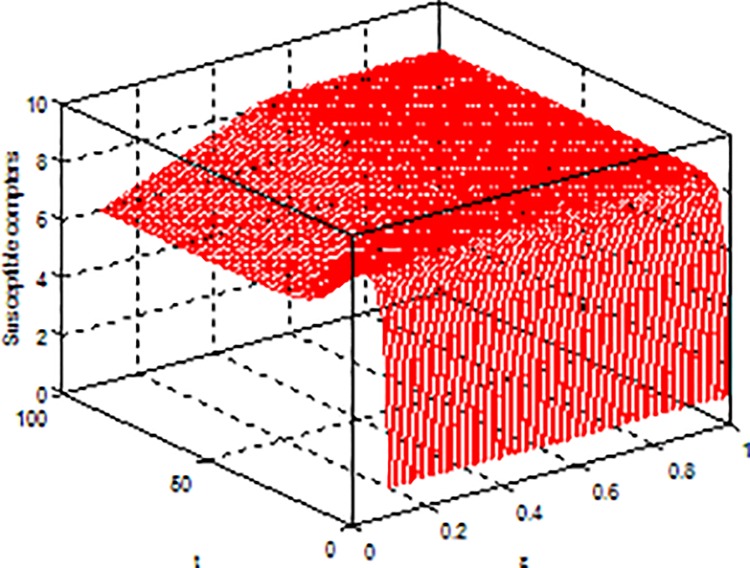
Dynamical behaviors of every system variable with parametersε-S(t.).